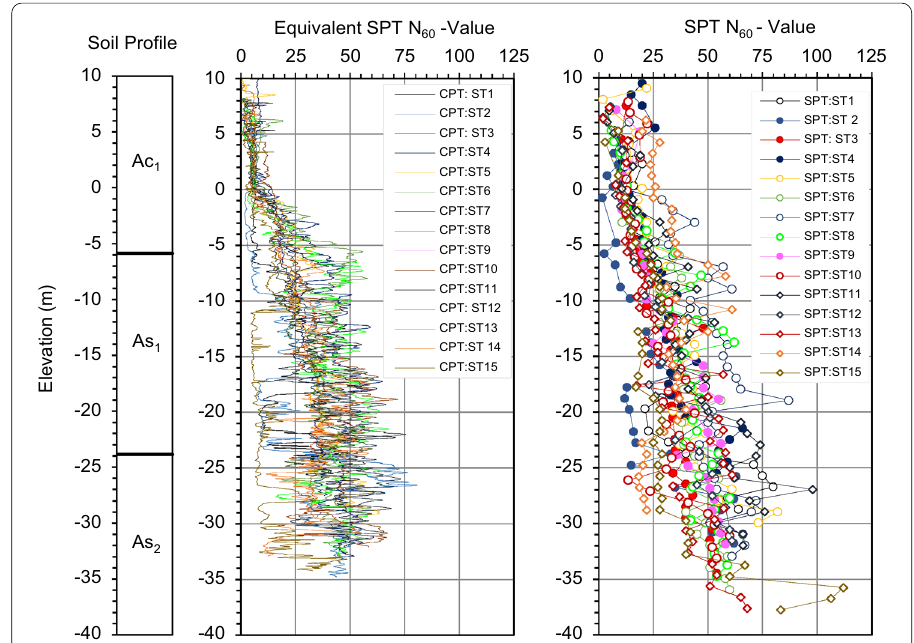
Fig. 2 Soil profile of Dhaka soil with equivalent SPT N -value and corrected SPT N -value with